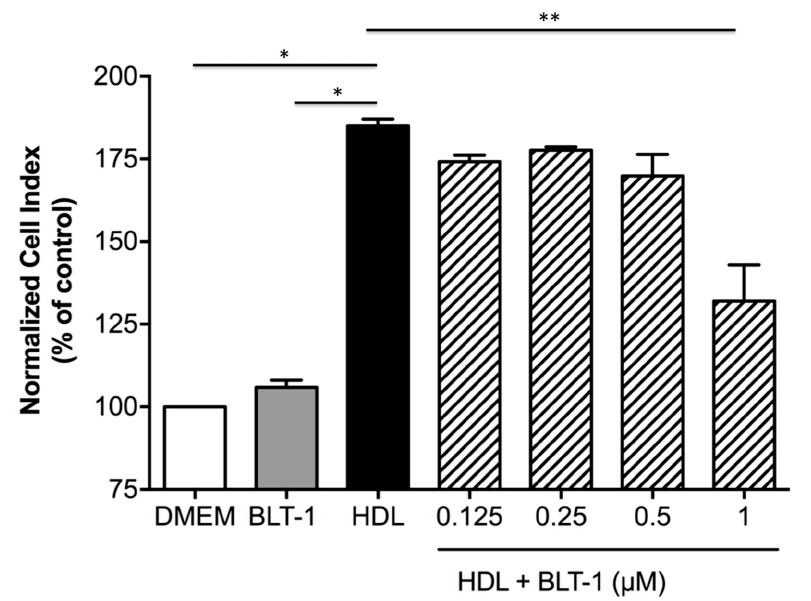
Figure 5. Role of endothelial SR-BI in the protective effects of HDLs on the integrity of a human cellular model of BBB in ischemia/reperfusion conditions. The role of endothelial SR-BI on the protective effects of HDLs on the integrity of hCMEC/D3 cell line BBB model in OGD/reperfusion conditions was assessed by the comparison of the normalized cell index (expressed as % of control) 4 h after incubation of hCMEC with or without increasing concentrations of SR-BI inhibitor BLT-1 from 0.125 to 1 µM. HDLs display protective effects on the integrity of the BBB compared to DMEM alone (* p < 0.05). Addition of 1 µM BLT-1 inhibited the protective effects of HDLs on BBB integrity (** p < 0.05), whereas 1 µM BLT-1 alone did not decrease cell index.